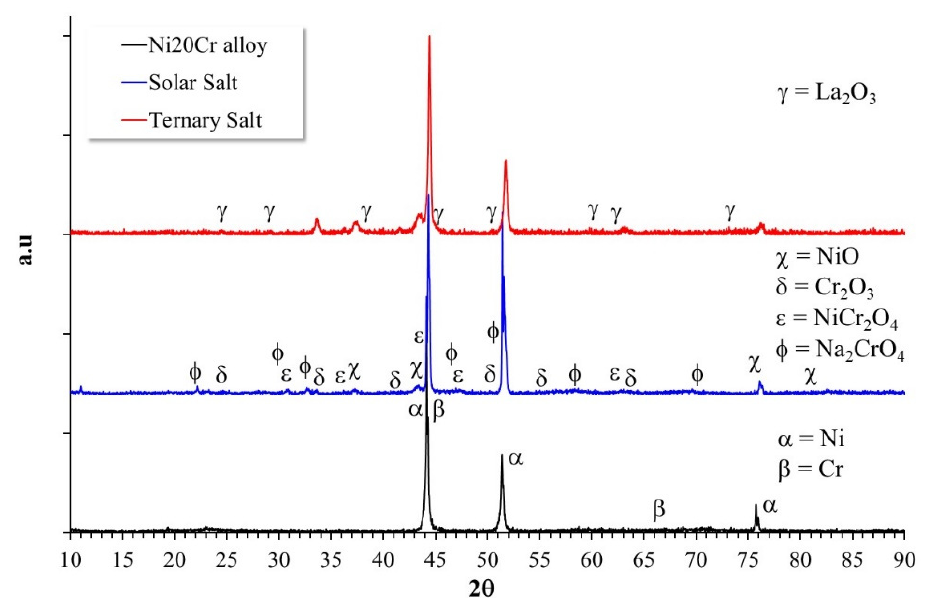
Figure 11. Diffractogram of the Ni20Cr alloy surface before and after the corrosion test on Solar Salt and ternary salt at 500 °C after 1000 h of immersion.